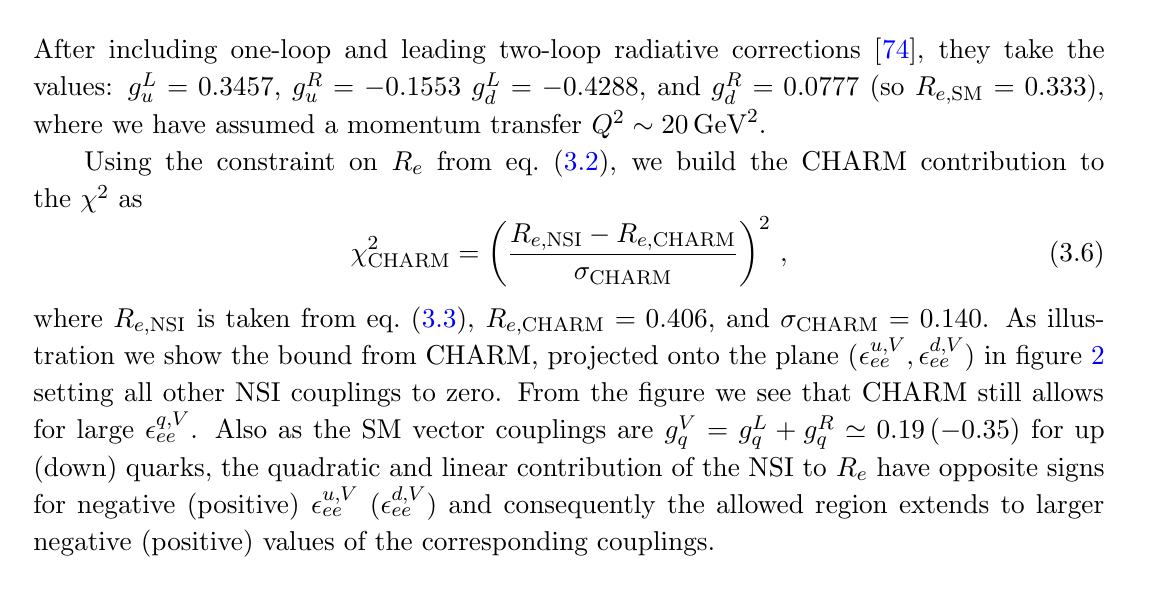
Figure 2 . Allowed region from the CHARM measurement on two vector NSI parameters, (cid:15) u;V and (cid:15) d;V (for all other NSI couplings set to zero). The black dot shows the SM input value, while ee colored regions correspond to the 1 ; 2 ; 3 (cid:27) contours for two degrees of